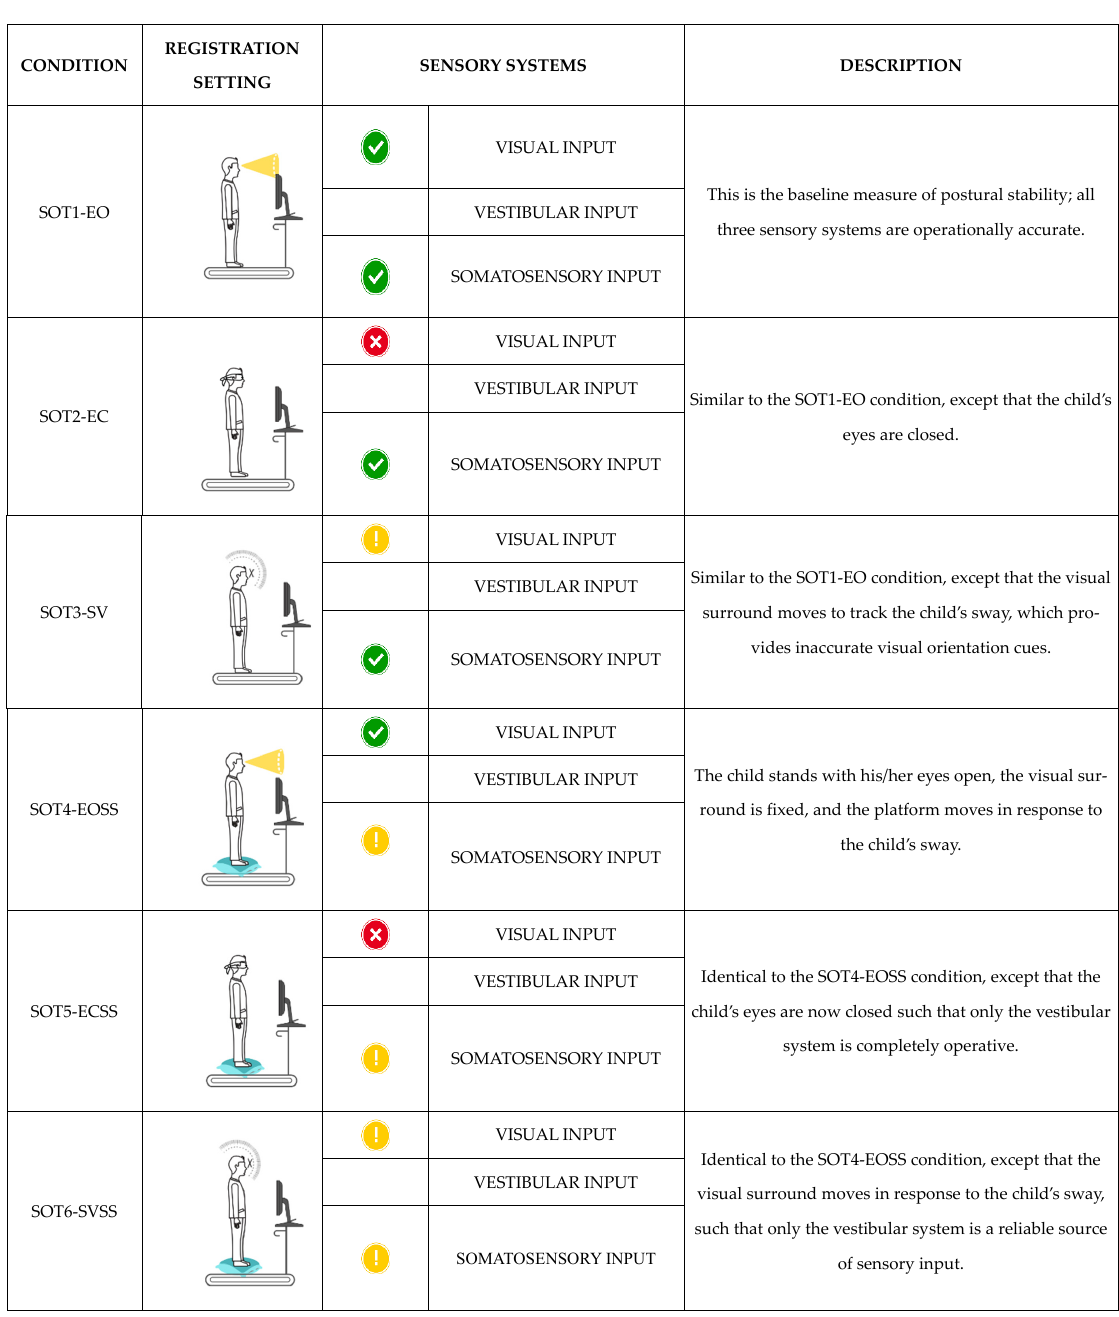
Figure 1. SOT: Sensory Organization Test; EO: Eyes Open; EC: Eyes Closed; SV: Sway-referenced Vision; EOSS: Eyes Open Sway-referenced Support; ECSS: Eyes Closed Sway-referenced Support; SVSS: Sway-referenced Vision Sway-referenced Support. Visual input is the sensation of any change in the visual environment. Vestibular input is the sensation of any change in position, direction, or movement of the head. Somatosensory input is the sensation of any change in, but not limited to, touch, temperature, posture, and limb position. Normal sensory input; absent sensory input; sway-referenced